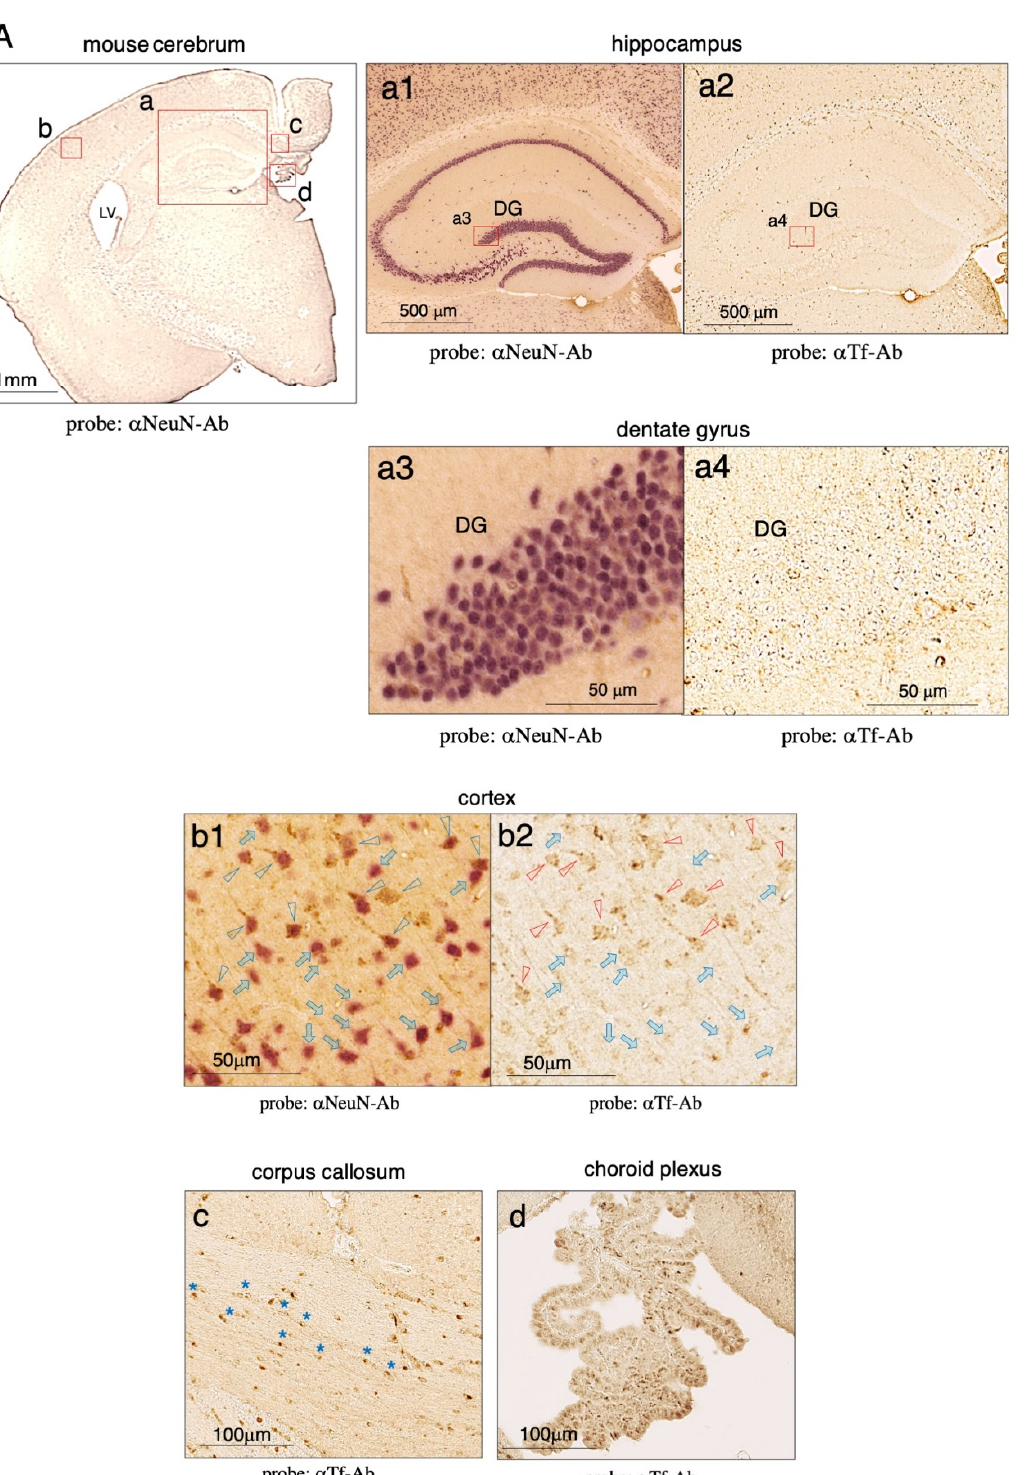
Figure 4. Immunohistochemistry of mouse brain sections stained with anti ‐ Tf antibody. Mouse brain sections were subjected to immunohistochemistry using an anti ‐ mouse Tf antibody ( A ). Lateral ventricle (LV) is shown. High magnification images of the hippocampus ( a ), cerebral cortex ( b ), corpus callosum ( c ), and choroid plexus ( d ) are also shown. Mirror ‐ image sections of the hippocam ‐ pus were stained with anti ‐ NeuN antibody ( a1 ) and anti ‐ mouse Tf antibody ( a2 ). High magnifica ‐ tion images of the dentate gyrus (DG) are shown ( a3 , a4 ). NeuN ‐ positive cells in the cortex are indi ‐ cated with blue arrowheads ( b1 ), and the same positions on the mirror ‐ image section are indicated with red arrowheads showing Tf antibody ‐ staining ( b2 ). NeuN ‐ positive but Tf ‐ negative neurons